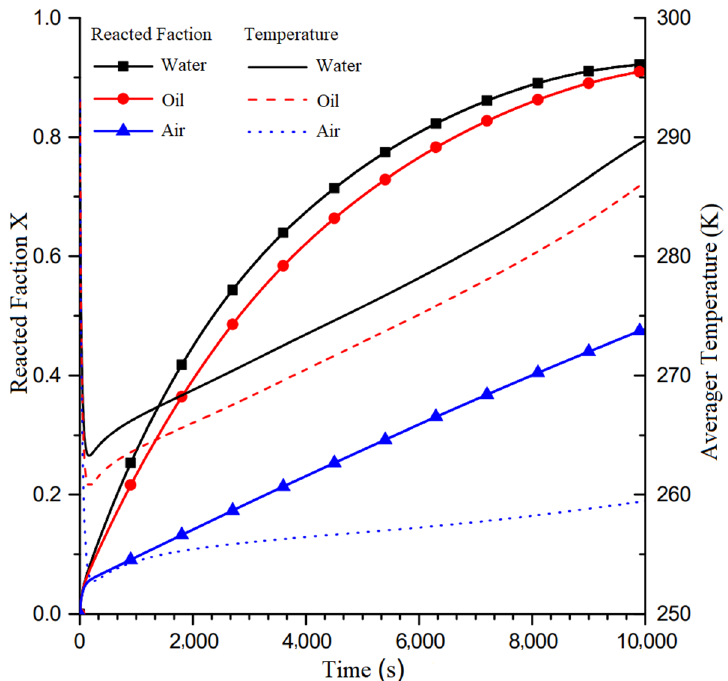
Figure 8. Time-varying curves of average temperature and the reacted fraction in the reaction zone in a condition of diverse heat transfer media